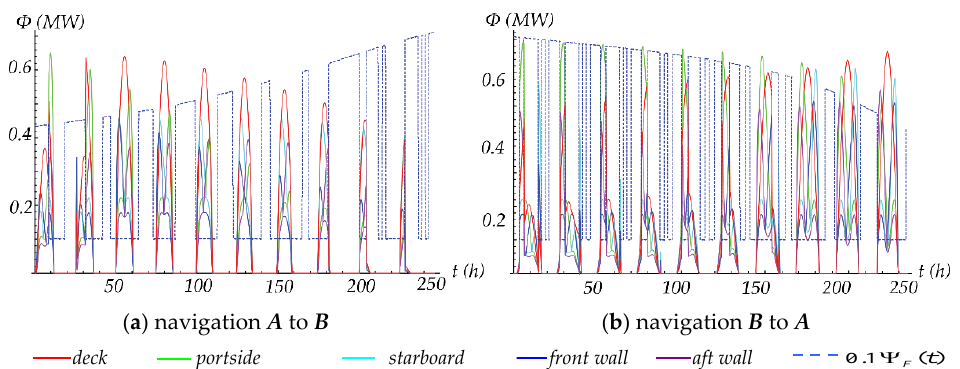
Figure 13. Overall solar irradiation for the ship’s accommodation enclosures during navigation through first transport cycle.